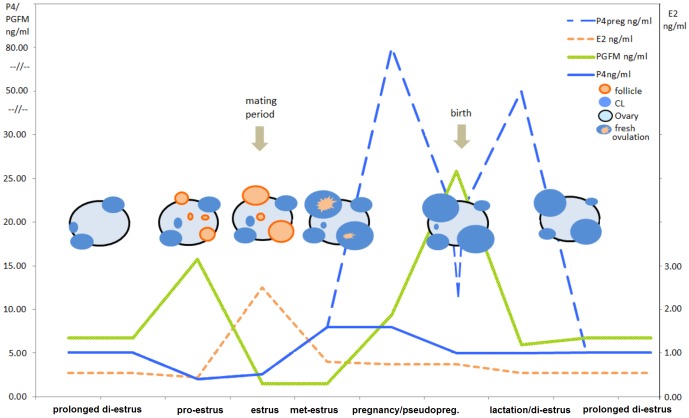
Schematic lynx ovarian cycle.Schematic diagram of the development of follicles and CLs within a reproductive year in pregnant and non-pregnant lynx. P4, E2, PGFM in ng/mL are shown with lines.